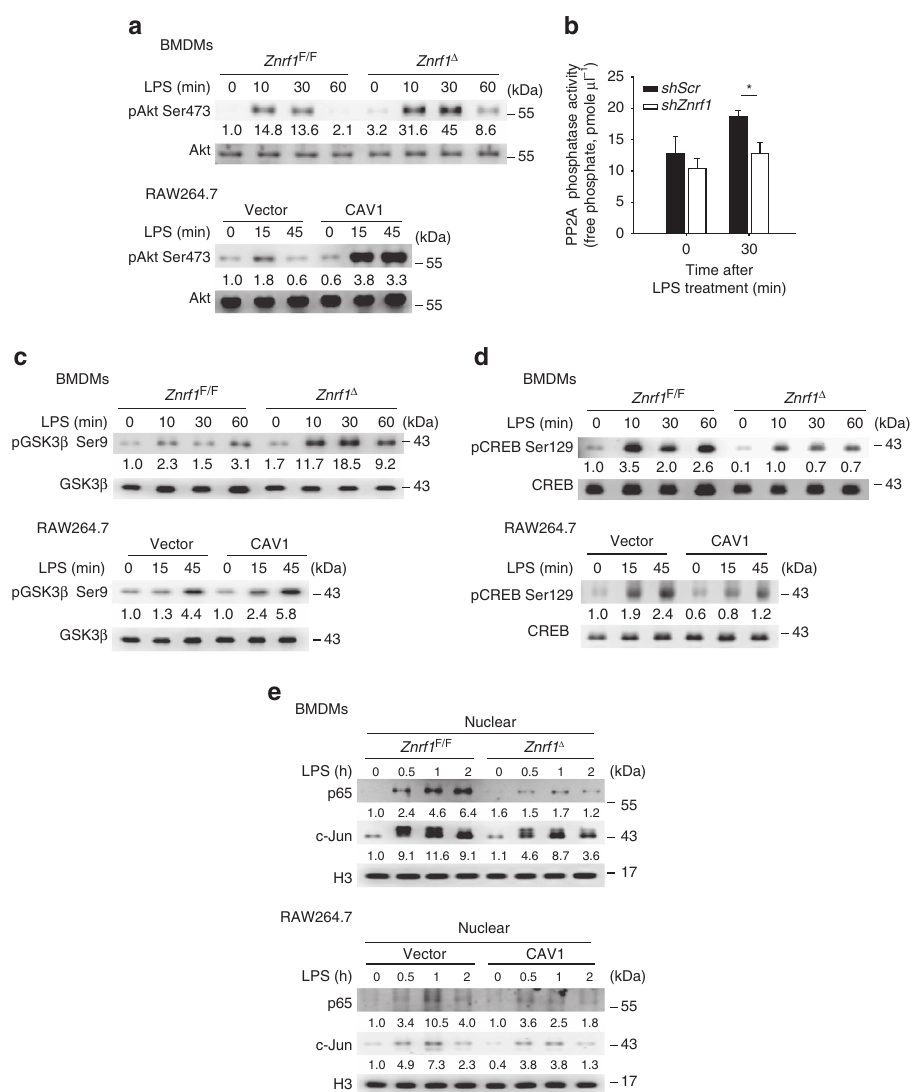
Figure 6 | Akt–GSK3 b –CREB signalling is altered in ZNRF1-deficient and CAV1-expressing macrophages in response to LPS. ( a , c , d ) Immunoblot analysis of the phosphorylation of Akt (Ser473), GSK3 b (Ser9) and CREB (Ser129) as well as total Akt, GSK3 b , and CREB in lysates of Znrf1 F/F and Znrf1 D BMDMs and vector- and CAV1-expressing RAW264.7 cells stimulated with LPS (100ngml (cid:2) 1 ) for the indicated times. ( b ) RAW264.7 macrophages infected with lentiviruses expressing shScr or shZnrf1 were treated with LPS (100ngml (cid:2) 1 ) for 30min, and cell lysates were prepared and PP2A catalytic subunit was immunoprecipitated followed by PP2A phosphatase activity analysis. ( e ) Immunoblot analysis of NF- k B p65 and c-Jun in nuclear extracts isolated from BMDMs and RAW264.7 cells described above. Histone H3 served as a marker for the nuclear fraction. The intensities of the bands are shown as fold increases compared to those of untreated control cells after normalization to their unphosphorylated forms or H3 expression. * P o 0.001 (Student’s t -test). The data are representative of three independent experiments performed in triplicate (error bars,